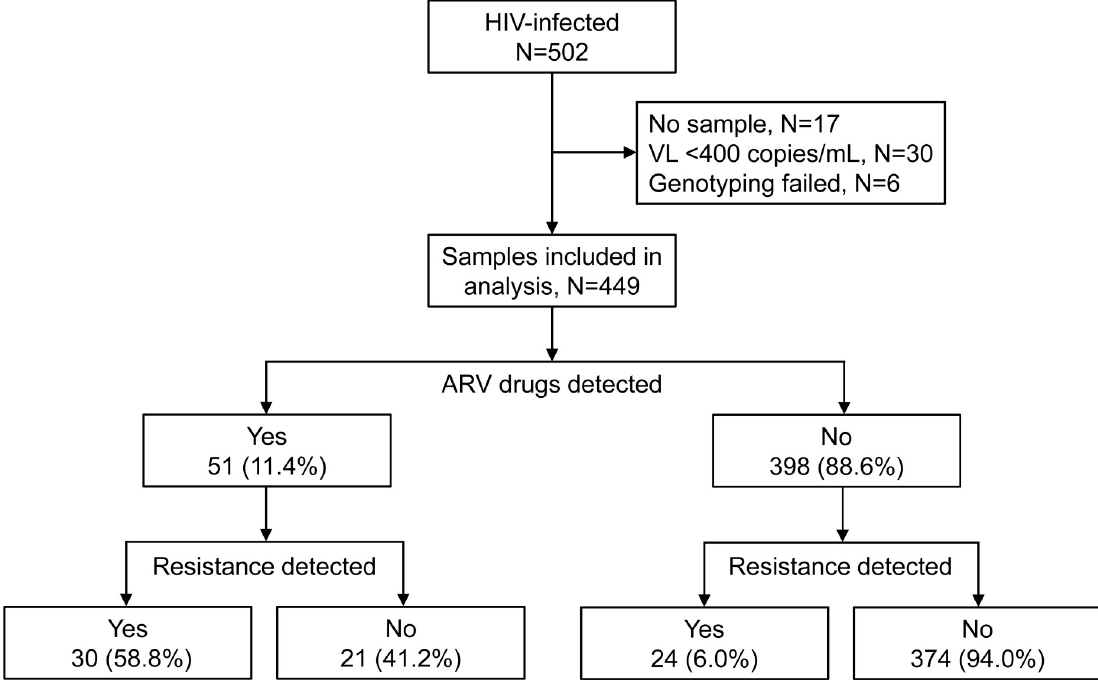
Fig 1. Overview of HIV drug resistance and antiretroviral drug testing. The figure shows a summary of the analysis of samples from HIV-infected participants enrolled in HIV Prevention Trials Network 074. HIV drug resistance detected refers to the detection of one or more major resistance mutations. Abbreviations: N, number; VL, viral load; mL, milliliter; ARV, antiretroviral.